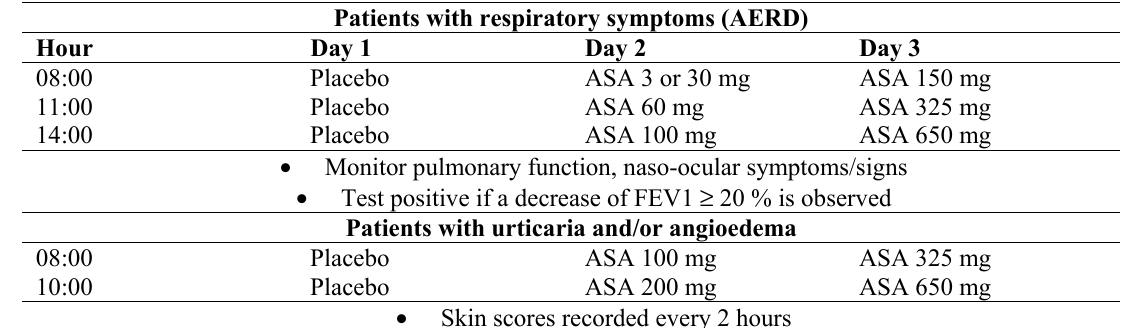
Table 2. Oral provocation tests with acetylsalicylic acid